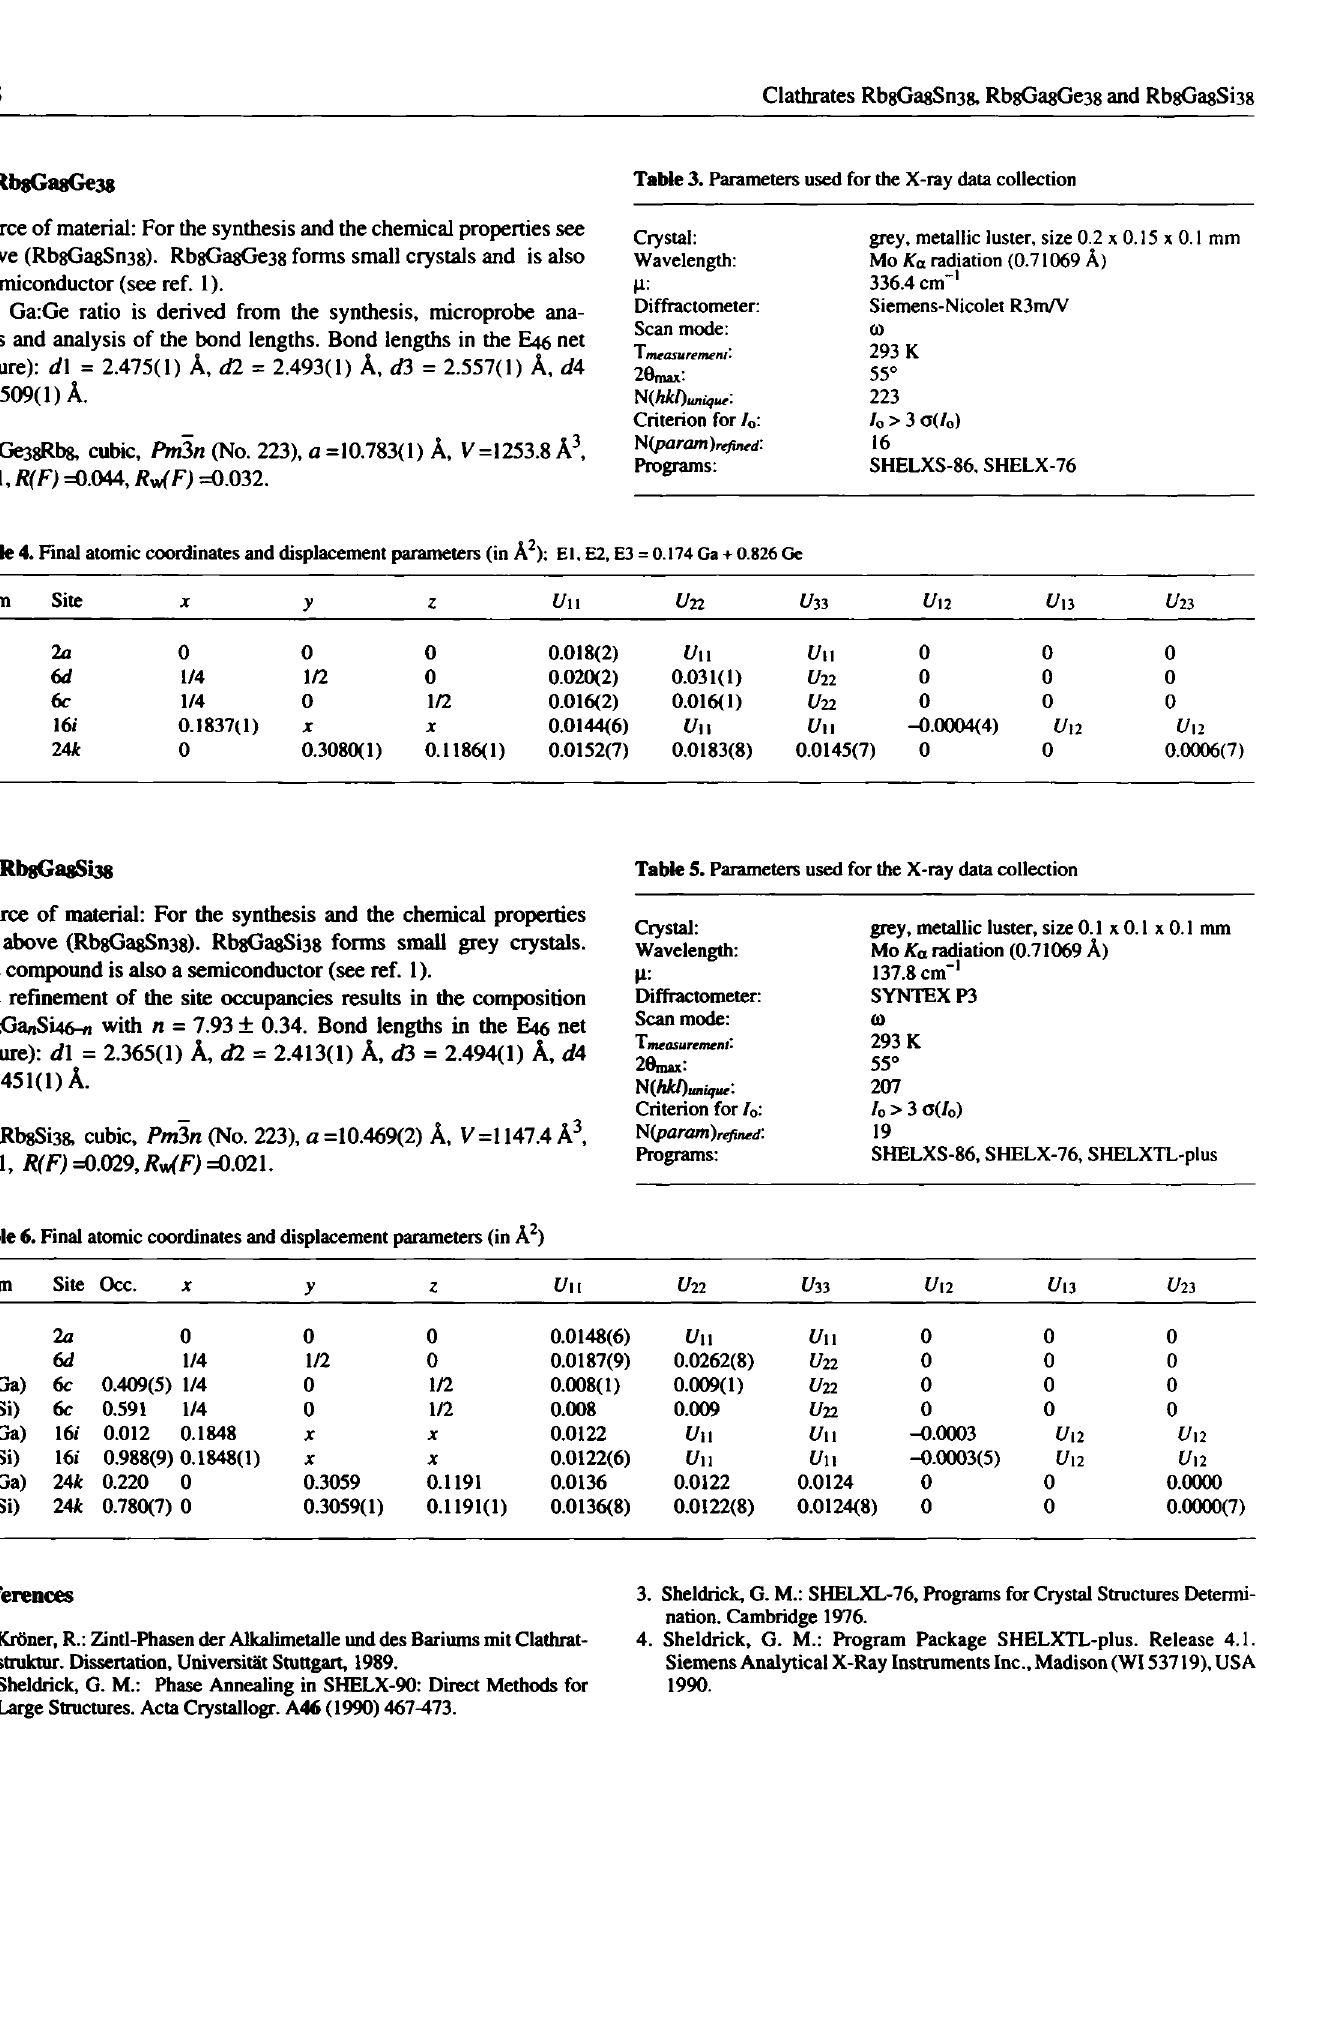
Table 3. Parameters used for the X-ray data collection Crystal: